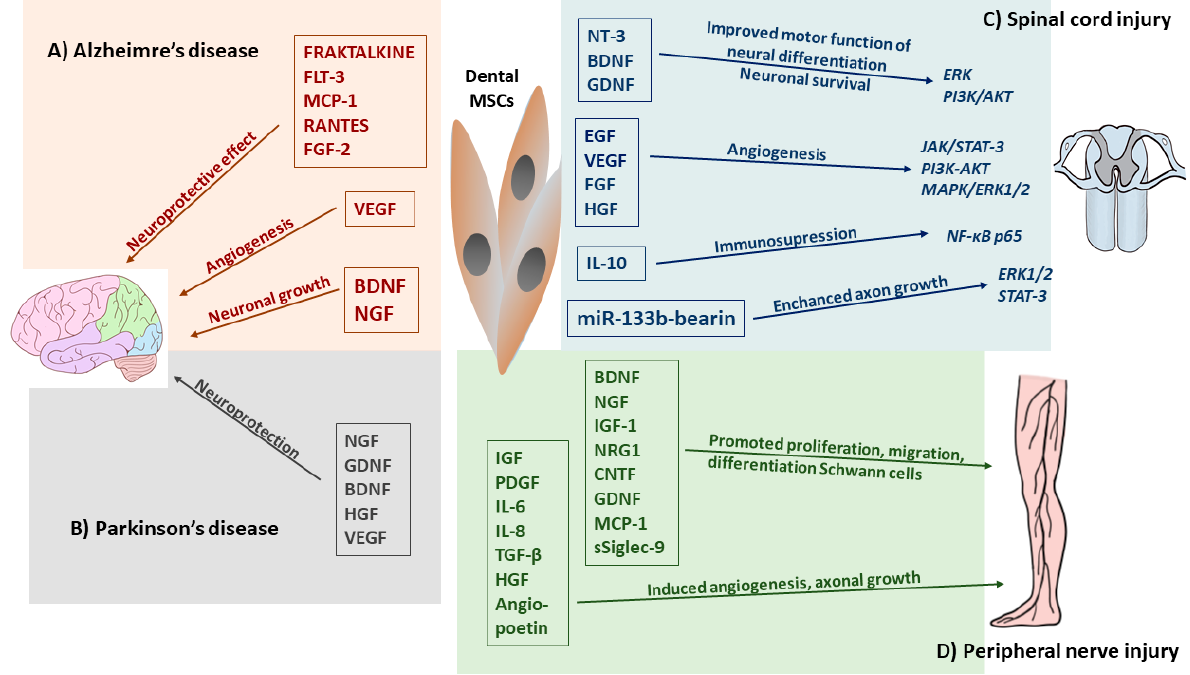
Figure 4. Effects of dental MSC – derived secretome in neurodegenerative diseases and central and peripheral nerve injury therapy. ( A ) Dental MSC-CM such as RANTES, FGF2, and Fractalkine enhanced neuronal cell survival and reduces apoptosis, BDNF, NGF involved in neuronal growth, whereas, VEGF promoted angiogenesis in Alzheimer’s disease. ( B ) Trophic factors (BDNF, NGF, GDNF, HGC, VEGF) and cytokines (TNF- α , IL-6) released by dental MCS-CM enhanced the regulatory function and reverts the damage sustained by host neurons in Parkinson’s disease. ( C ) Released by dental MSCs neurotrophic factors promoted neuronal differentiation and survival by activation of Erk, PI3/AKT and growth factors induced angiogenesis through JAK/STAT3, PI3K/AKT MAPK/Erk1/2 signaling pathways. Administration of dental MSC-EVs, miR-133 bearing promoted recovery form SCI by enhancing regeneration of axons through the activation of survival Erk1/2 and STAT-3 signaling pathways in regenerating neurons. Dental MSC-EVs induced immunosuppression at the site of SCI by enhancing production of IL-10 which suppressed neurotoxic A1 astrocytes through the inhibition of NF- κ B-p65 signaling pathways. ( D ) Dental-MCS-derived secretome modulates nerve regeneration of peripheral nerve injury (PNI) by secretion of many neurotrophic factors which promoted survival of neuronal and glial cells, whereas, MCP-1 and sSiglec-9 molecules enhanced neurite extension of peripheral nerve. Cytokines and growth factors secreted by dental MSCs enhanced angiogenesis in PNI.